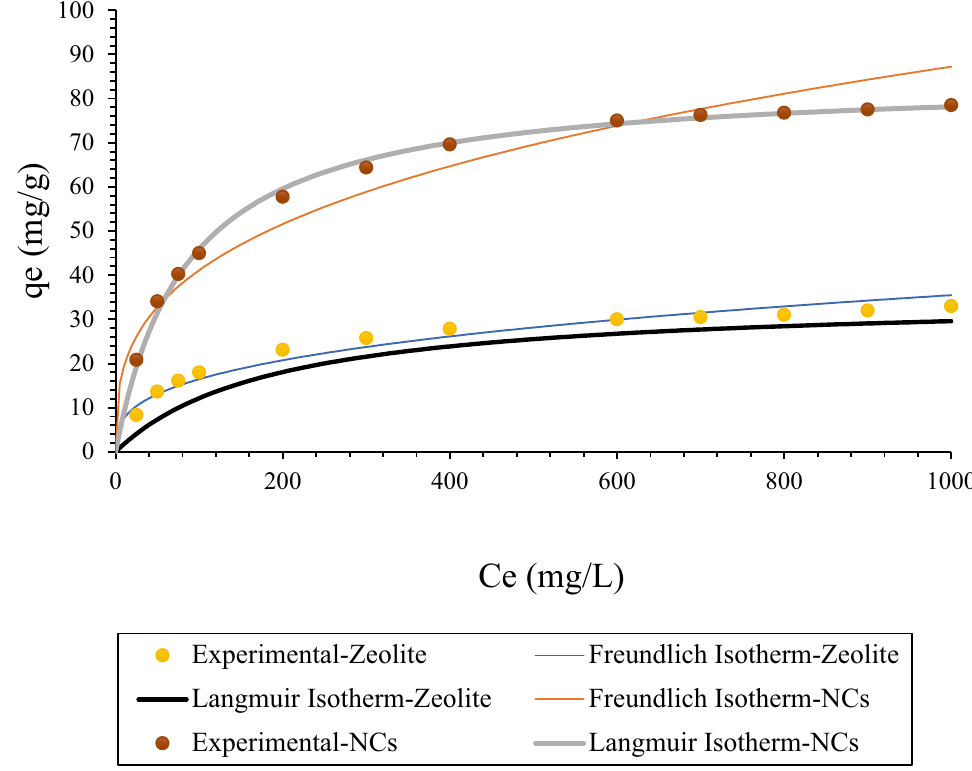
Figure 7. Asphaltene adsorption models (Langmuir and Freundlich) for NCs and zeolite